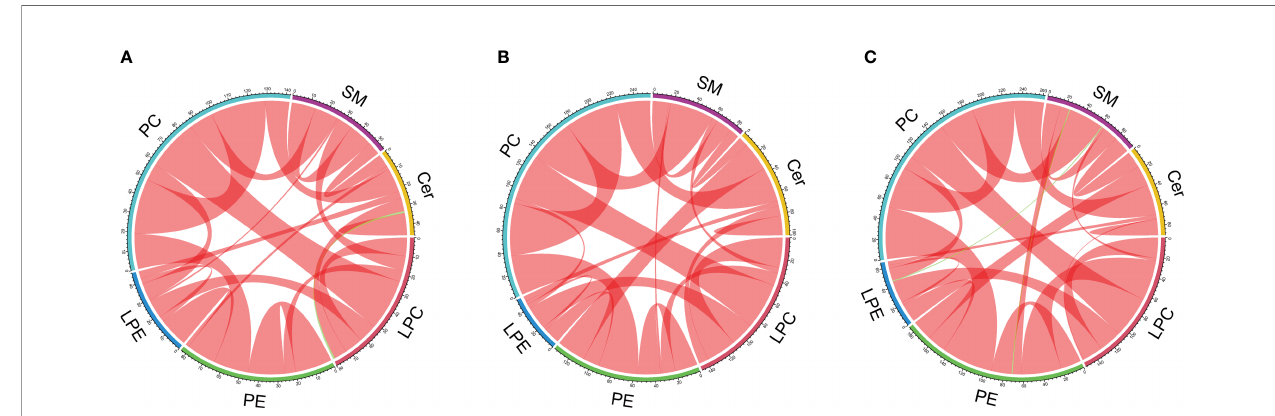
FIGURE 5 | Chord diagrams of signi fi cant (P<0.05) pairwise correlations between lipids for the control group (A) , T2DM patients before exenatide treatment (B) , and T2DM patients after exenatide treatment (C) respectively. The colored arcs outside of the circle represent 6 lipid classes. Signi fi cant correlations between every pair of lipid species are depicted by sectors, with red representing positive correlation and green representing negative correlation. Bandwidth corresponds to the number of correlated pairs. LPC, lysophosphatidylcholine; PE, phosphatidylethanolamine; LPE, lysophosphatidylethanolamine; PC, phosphatidylcholine; SM, sphingomyelin; Cer,